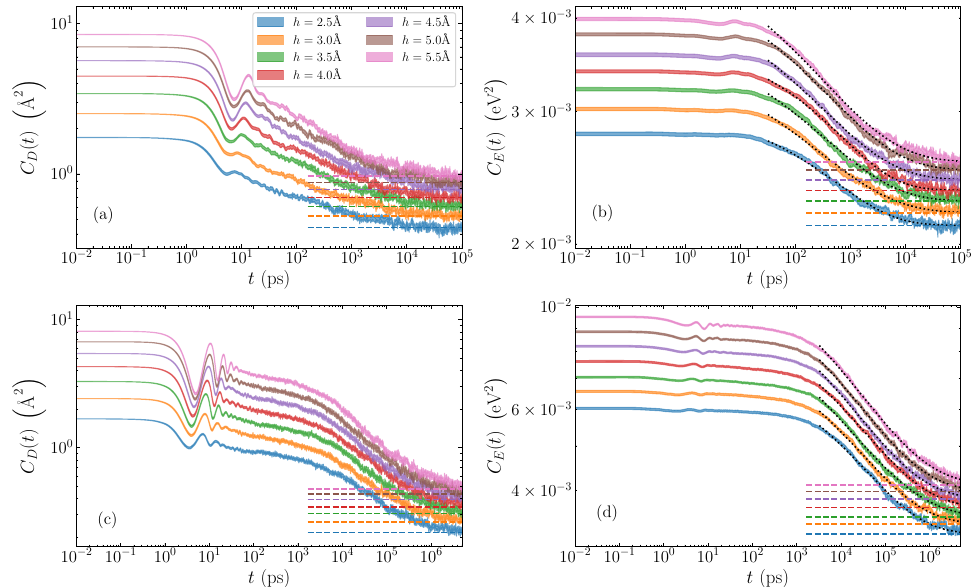
Figure 2. Time evolution of the average autocorrelation functions for homogeneous AT and GC sequences and different initial bubble amplitudes ranging from h = 2.5 Å to h = 5.5 Å. The shaded region gives the average value plus and minus the standard deviation of the mean. Top row: AT sequences, for a bubble width of w = 19 base pairs; ( a ) displacement autocorrelation functions C D ( t ) , (Equation (5)), and ( b ) energy autocorrelation functions C E ( t ) (Equation (8)). Bottom row: GC sequences with a bubble width of w = 11 base pairs; ( c ) displacement and ( d ) energy autocorrelation functions. In all cases, the dashed lines mark the expected limiting values χ D and χ E from Equations (6) and (9), respectively. Dotted lines in ( b , d ) represent stretched exponential fittings with Equation